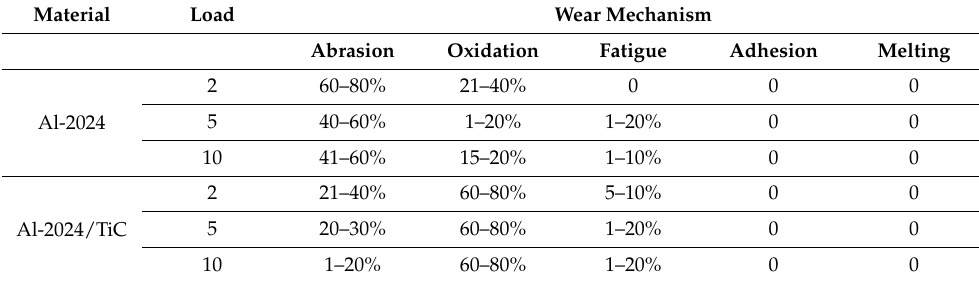
Table 4. Wear mechanisms present over worn tracks of